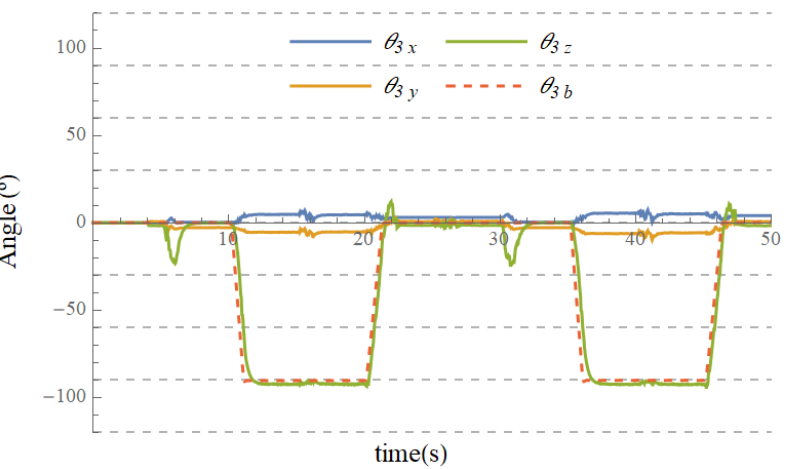
Figure 9. Evolution of Rotation Vector 3 when testing the link model using only accelerometer